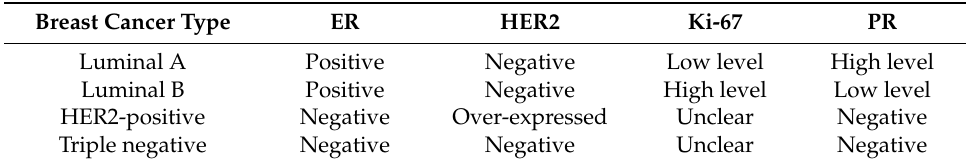
Table 1. The classification of breast cancer sub-types based on the expression of biomarkers in tumors. ER: estrogen receptor; HER2: human epidermal receptor 2; Ki-67: a protein marker for proliferation; PR: progesterone